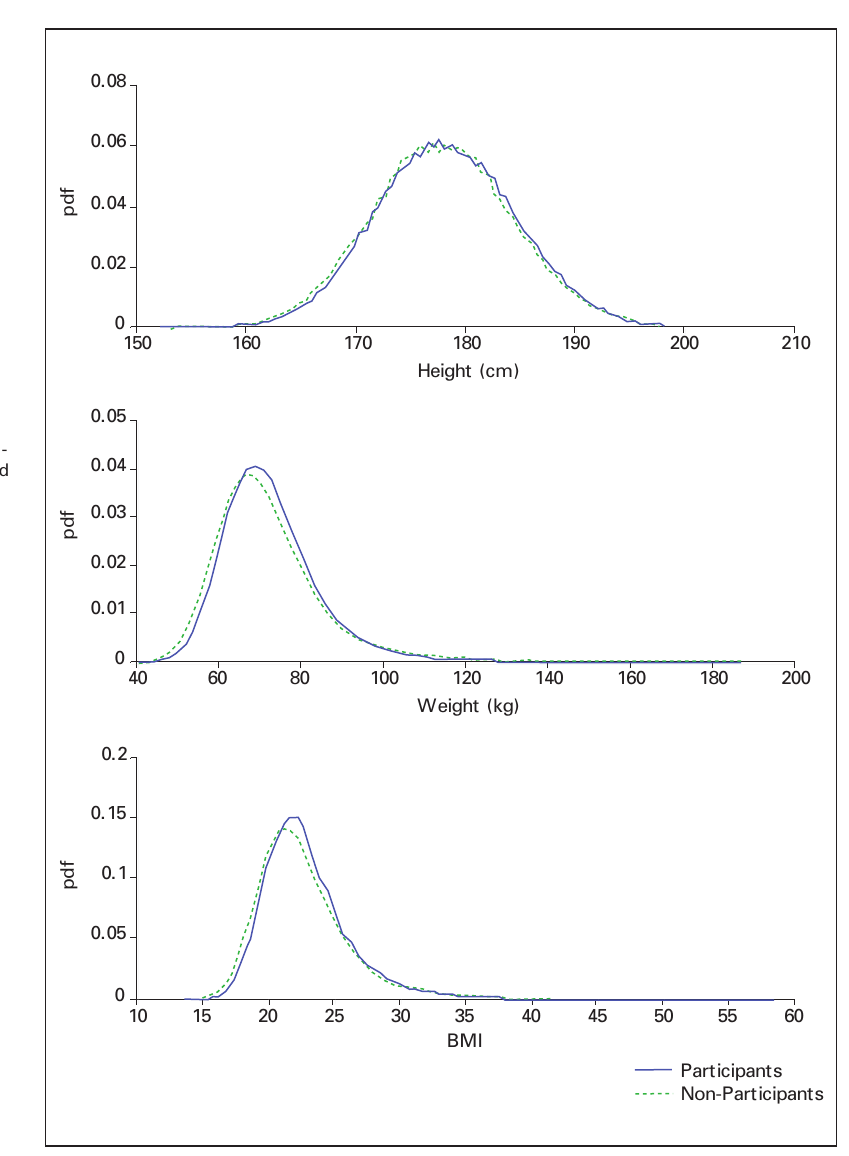
Figure 6 Distribution of